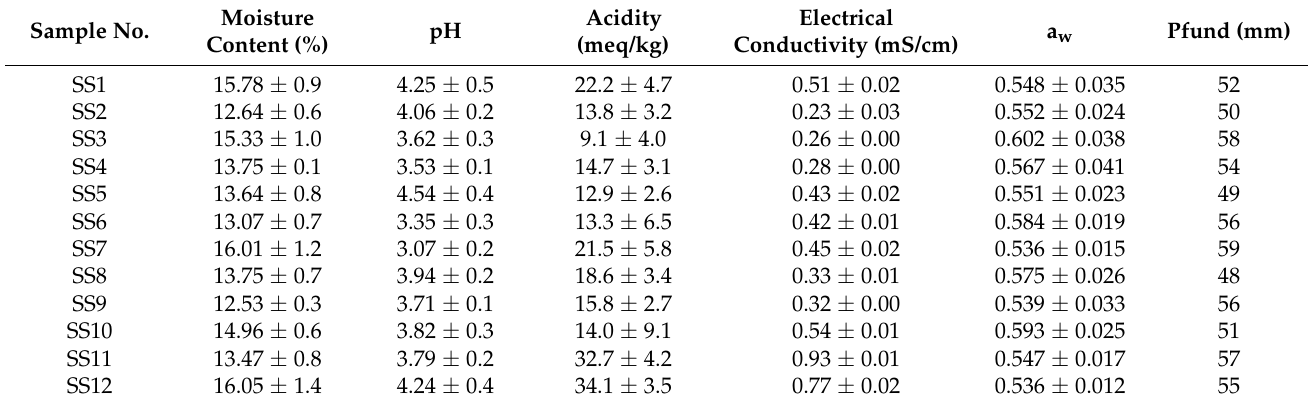
Table 2. Physicochemical parameters of honey samples from Alba County.